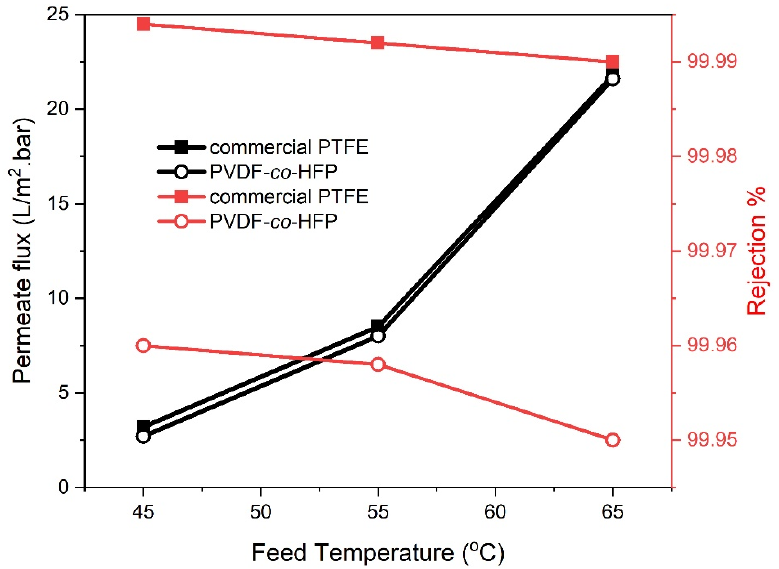
Figure 3. E ff ect of feed temperature on permeate flux and salt rejection for 35 g / L NaCl feed solution, 0.6 L / min feed flow rate and 300 L / h sweeping gas flow rate for PTFE and PVDF-co-HFP Figure 3. Effect of feed temperature on permeate flux and salt rejection for 35 g/L NaCl feed solution, 0.6 L/min feed flow rate and 300 L/h sweeping gas flow rate for PTFE and PVDF-co-HFP membranes.